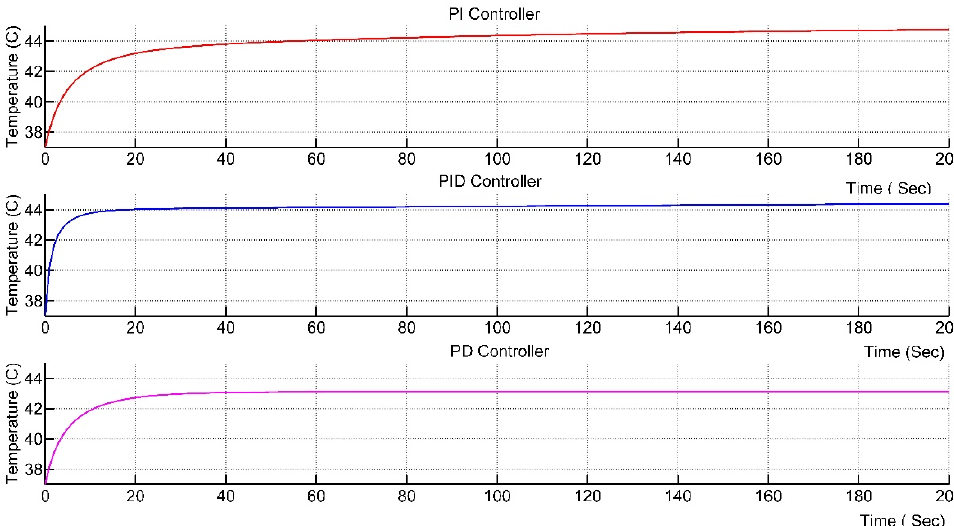
Figure 7. Step Response of PI, PID and PD controllers.